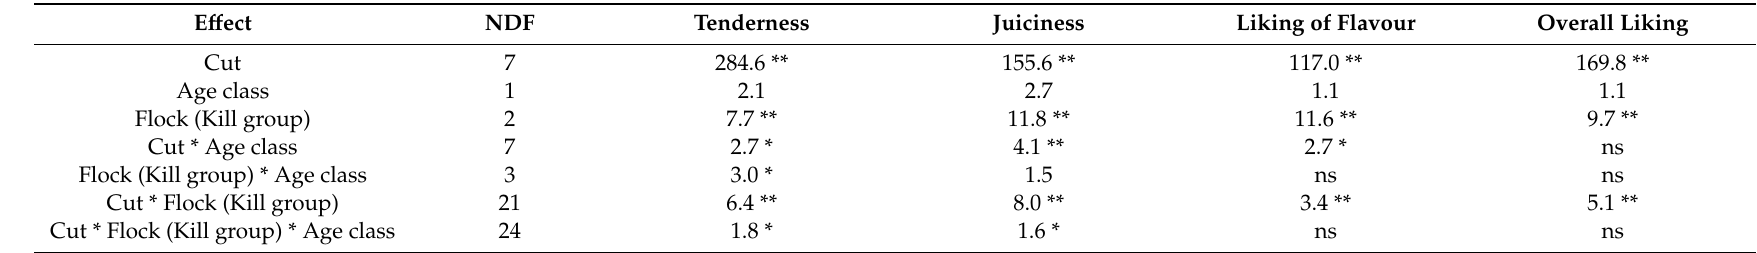
Table 3. Numerator degrees of freedom and F-values for the e ff ects of the base linear mixed e ff ects models of the tenderness, juiciness, flavour and overall liking